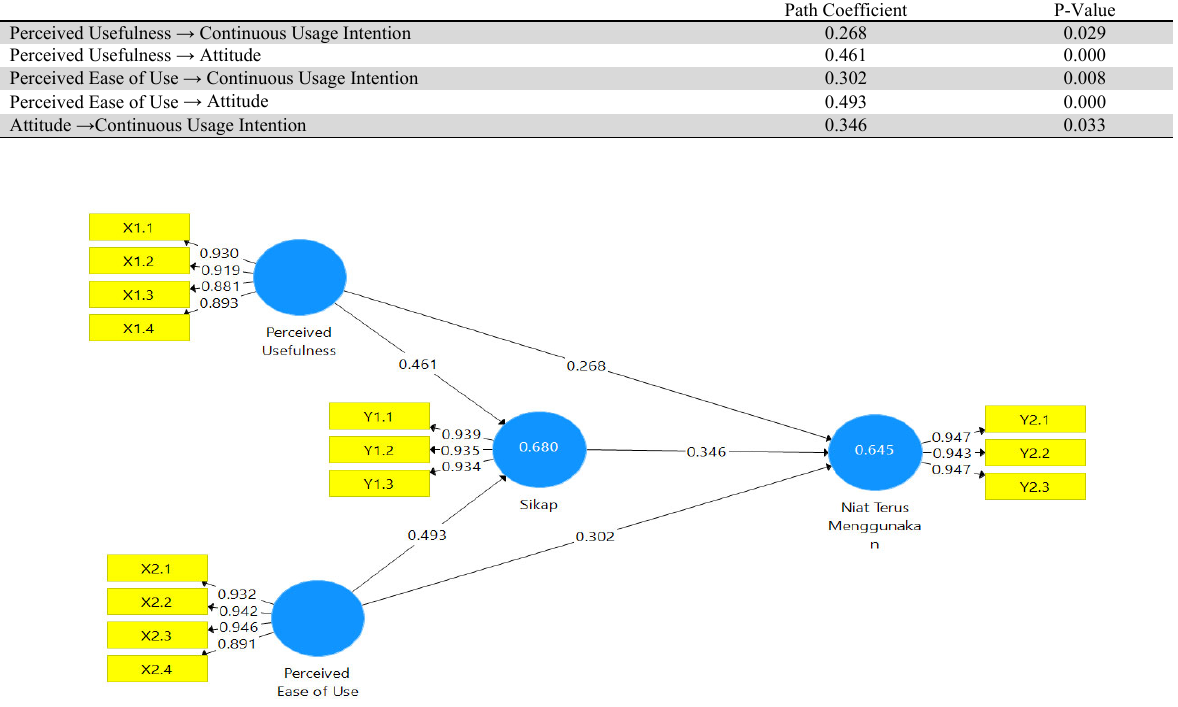
Direct Effect Test Results